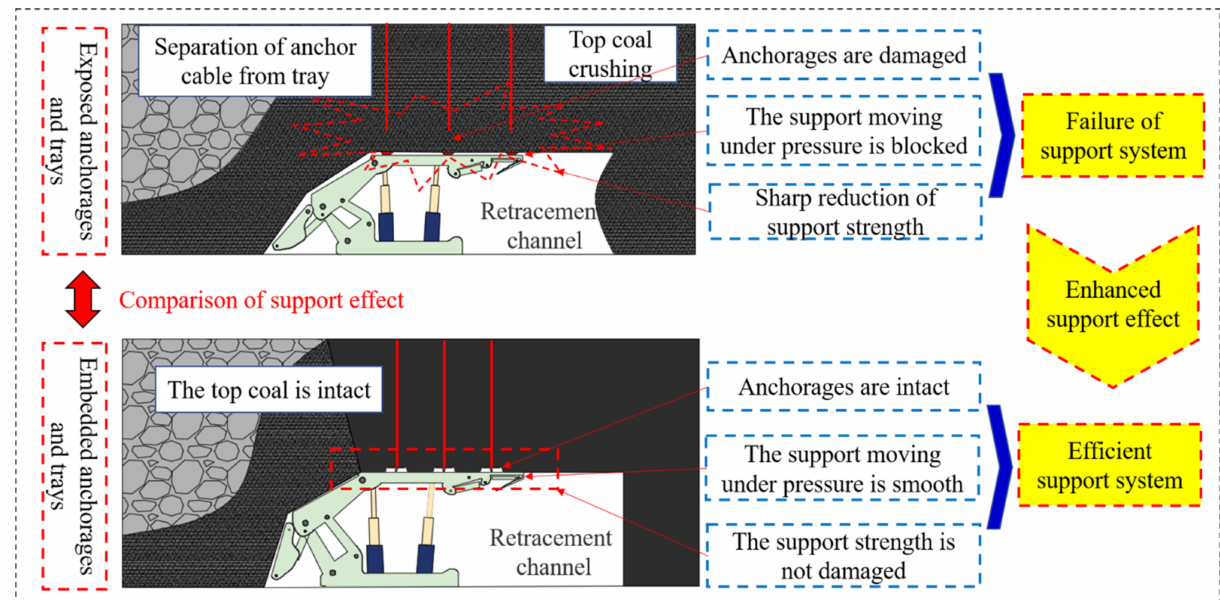
Figure 21. Comparison of the effect between exposed and embedded anchorages and